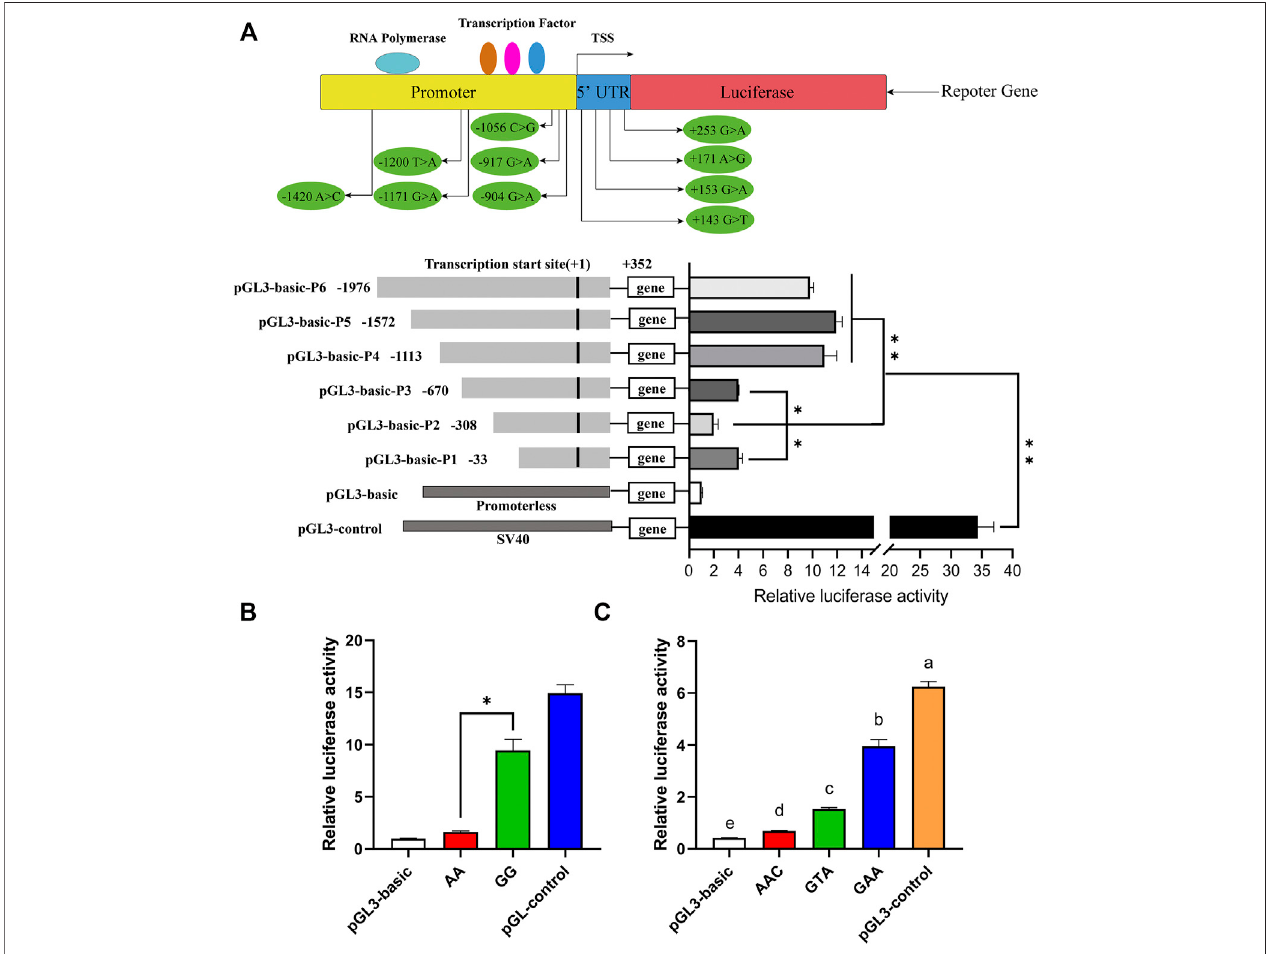
FIGURE 3 | Luciferase assays for porcine ARHGAP24 promoter activity analyses. PGL3-basic as a negative control and PGL3-control as a positive control. (A) Gene promoter diagram and the location ofSNPs in the promoter region and the 5 ′ UTR. A total of sixluciferase reporter plasmids expressing successive truncations of the ARHGAP24 promotersequencewereconstructedandtransfectedintoHEK293Tcells. (B) Luciferasereportergeneassaysofporcine ARHGAP24 allelescontained rs335052970 ( − 744G > A). (C) Luciferase activities of plasmids contained three haplotypes of the porcine ARHGAP24 gene. The relative luciferase activity values represent the mean ± SEM of three independent experiments. Statistical differences in luciferase activity were assessed using the one-way ANOVA; * p < 0.05 and ** p < 0.01. Different letters (a, b, c, etc .) indicate that the difference is signi fi cant ( p < 0.05).